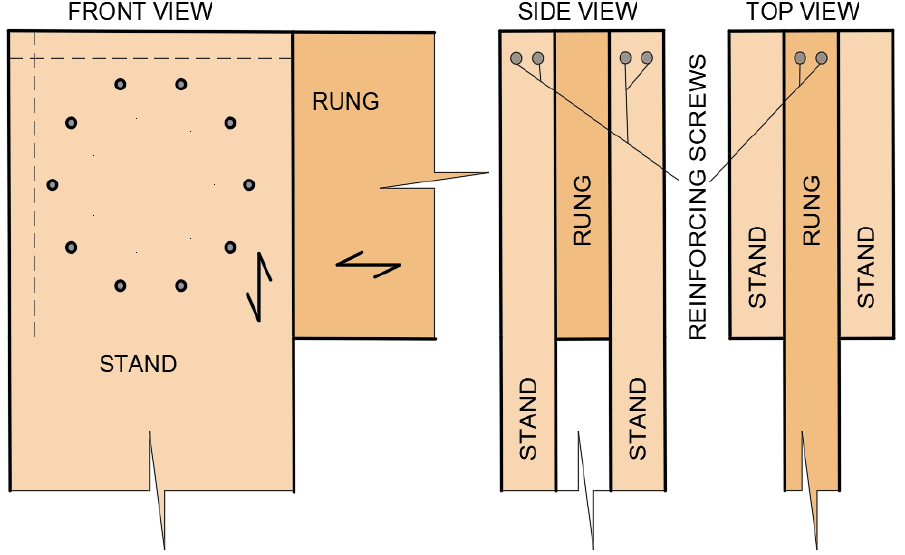
Figure 1. Reinforcement of the frame connection from the point of view of increasing the ductility of the connection.